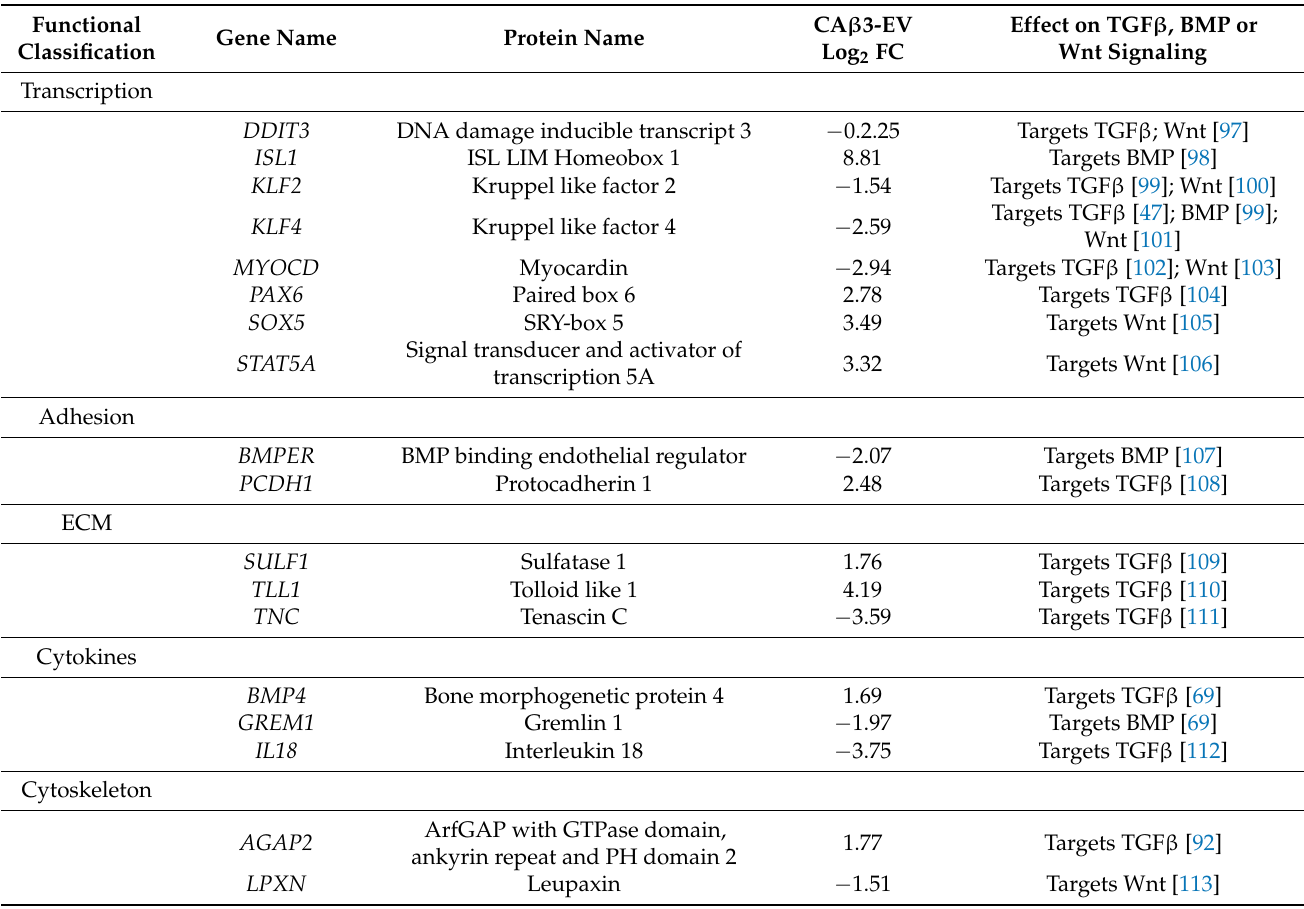
Table 7. Differentially expressed genes in CA β 3 cells that target TGF β 2, BMP or Wnt signaling. Log 2 FC values were reported in DGE analysis using